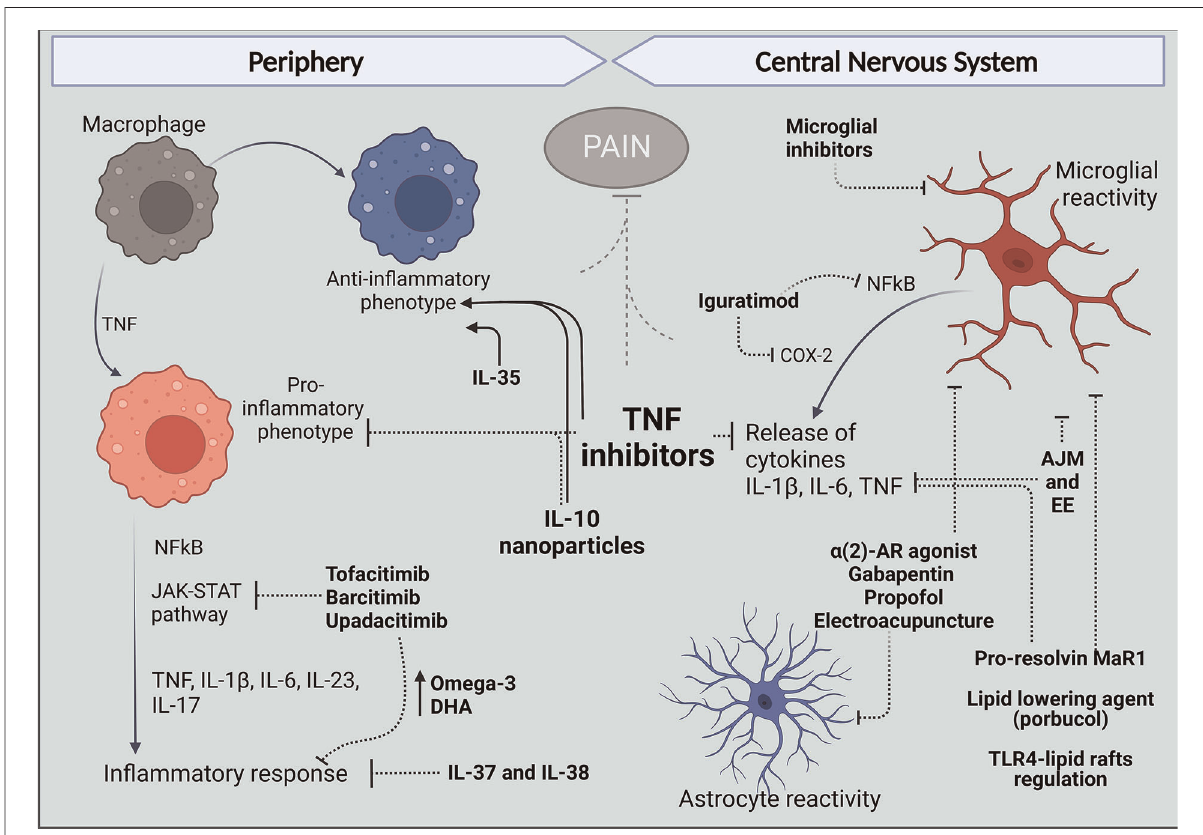
FIGURE 2 Treatments that target peripheral and central mechanisms involving macrophages and glial cells for the control of neuroin fl ammation and pain in RA. In The periphery, targeting TNF with antibodies such as ADA and anti-in fl ammatory cytokine administration like IL-10 have reduced the release of pro-in fl ammatory cytokines and reduce polarization of macrophages in the synovium to an M1 phenotype and, in contrast favor polarization to the anti-in fl ammatory M2 pro fi le. Different inhibitors of JAK kinases and treatments with IL-37 and IL-38 have been reported to increase anti- in fl ammatory Omega-3 and PUFAs and reduce cytokine release and in fl ammatory response. Centrally, evidence in arthritic models suggests articular joint movement and environment can affect glial reactivity as well as alpha 2-AR agonist, gabapentin, propofol, and electroacupuncture. Pro-resolving lipids and lipid-lowering agents have been shown to inhibit glial increased reactivity in fl ammatory response and produce analgesia. And in models different from arthritis, DMARDs have been shown to have an effect in microglia, targeting in fl ammatory mechanisms described for these cells in the spinal cords and brains of mice models of arthritis. Figure created with Biorender.com. ADA, adalimumab; AJM, articular joint movement; EE, environment enrichment; Mar1, maresin-1; DHA, docosahexaenoic